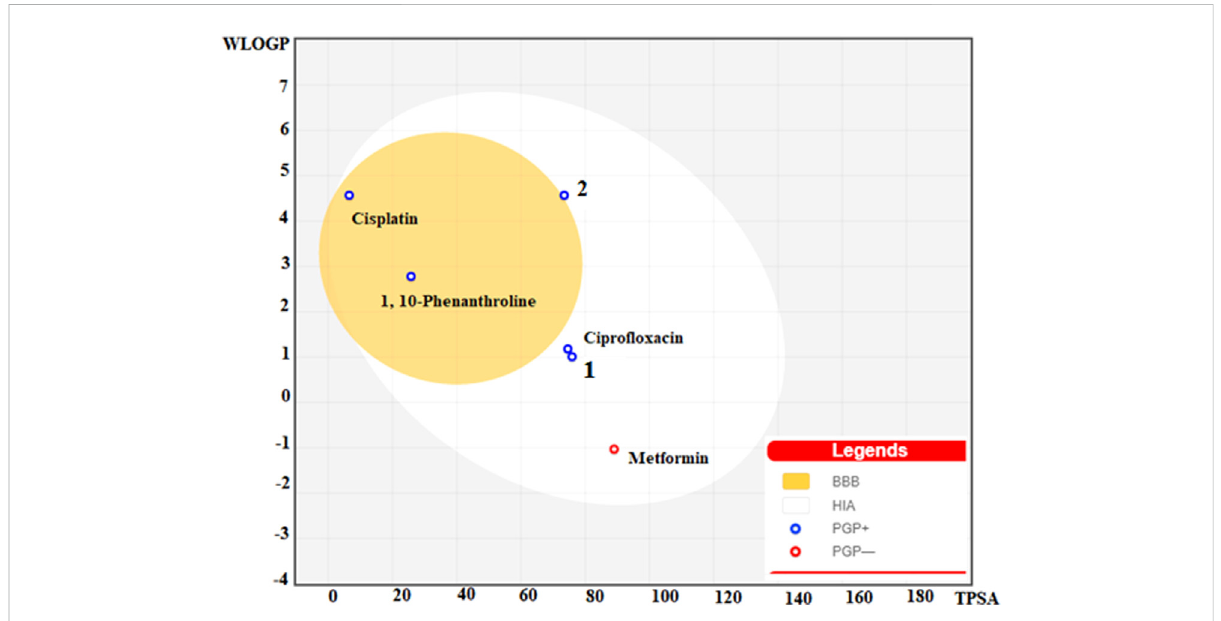
FIGURE 8 BOILED egg model of the ligands (1,10-Phenanthroline, Cipro fl oxacin, and metformin), 1, 2 and